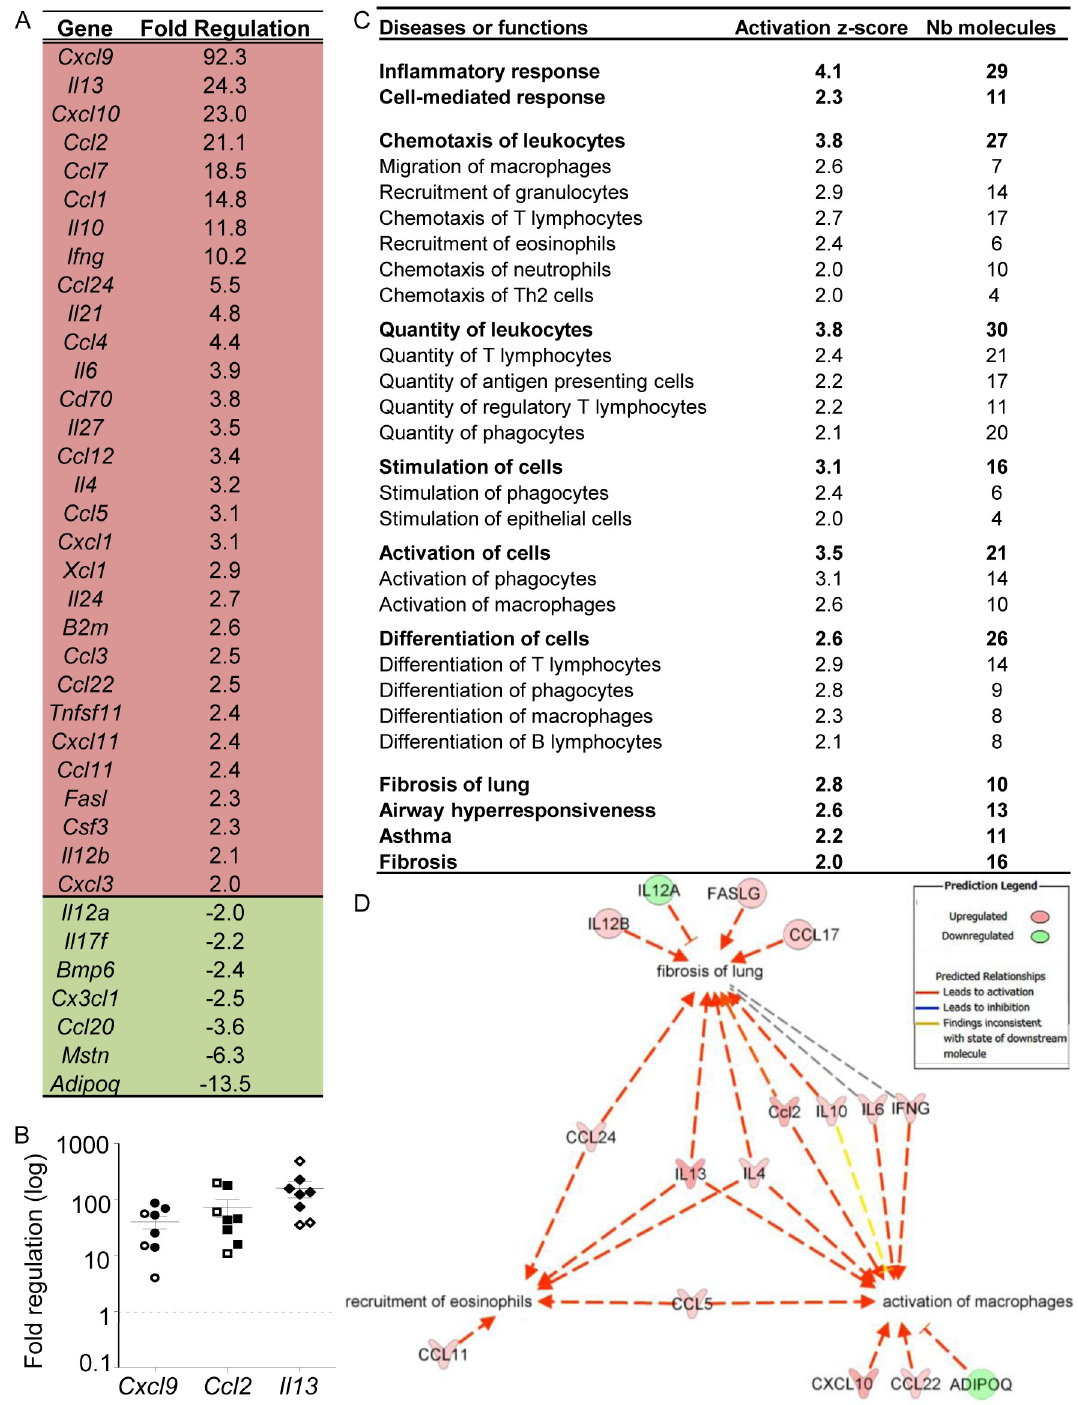
Fig 2. Analysis of cytokine gene expression changes in lungs during filarial infection. Lungs were recovered from L . sigmodontis infected BALB/c mice at 70 days p.i. and processed for gene expression profiling of cytokines/chemokines. ( A ) Analysis of differentially expressed genes; Fold change cut-off > 2; cDNA pools from 8 naive and 8 infested mice; ( B ) individual qRT-PCR analysis for Cxcl9 , Ccl2 and I113 transcripts; results are expressed as mean ± SEM (n = 8 naive and 8 infested mice). Plain symbols indicate microfilaremic mice, open symbols correspond to amicrofilaremic mice ( C ) Pathway analysis of selected gene-related functions reveals a strong inflammatory reaction in infected lungs. Gene expression profiles were analyzed with Ingenuity Pathway Analysis (IPA) to predict the functional consequences of the infection. The first column indicates the main diseases or functions